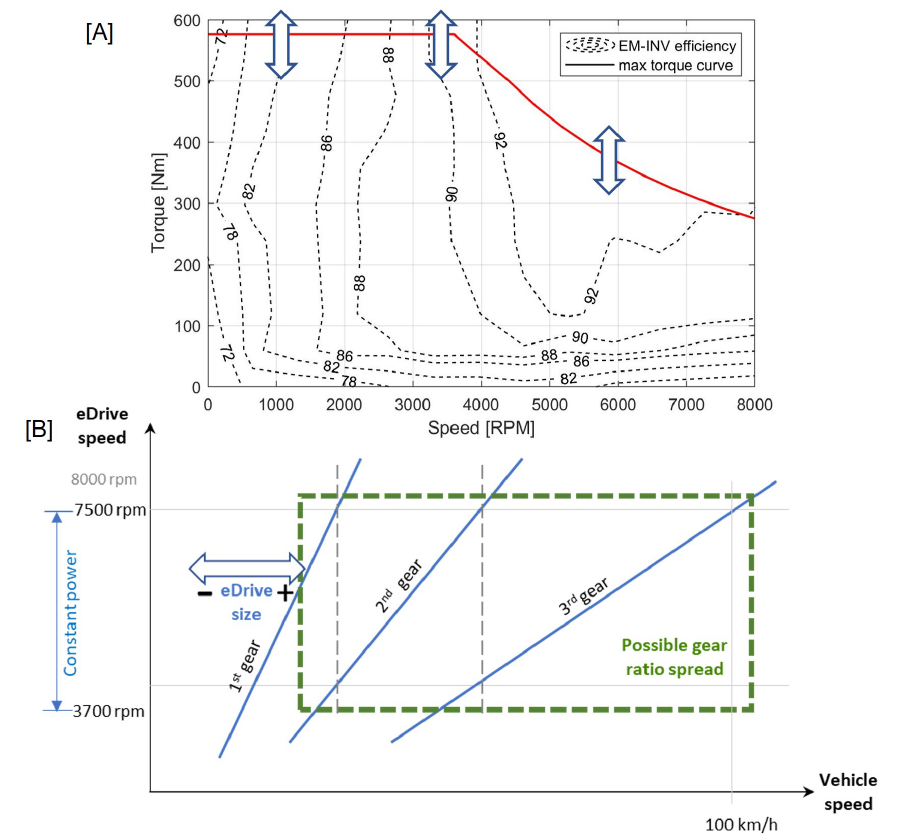
Figure 7. ( A ) eDrive electrical efficiency map with sizing based on maximum torque curve. ( B ) Traction chain sizing methodology including the effect of eDrive scaling on possible gear ratio search space.